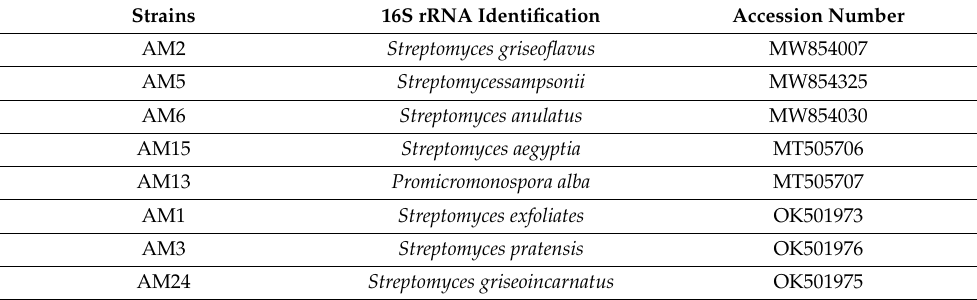
Table 3. 16S rRNA identification of the eight selected isolates.